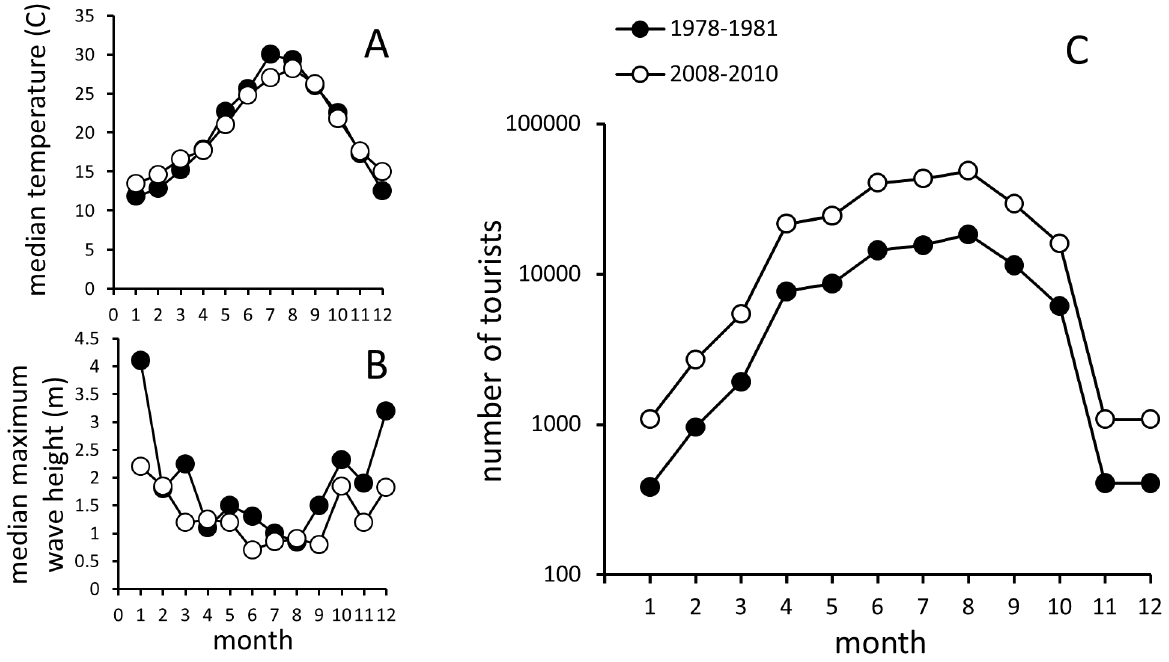
Figure 2. Local temperature, wave height and tourist arrival data for the studied time intervals. (a) Median monthly air temperature recorded at the Meteorological Station of Reus Airport (data provided by Servei Meteoro`logic de Catalunya); (b) Median maximum monthly wave height measured at a buoy (Simar-44 [2057048]) located proximally to the study area (publicly available data obtained from http://www.puertos.es; Puertos del Estado, Ministerio de Fomento); (c) A log-linear plot of monthly tourist arrivals for the 1978–1981 and 2008–2010 time intervals (see text for data sources).